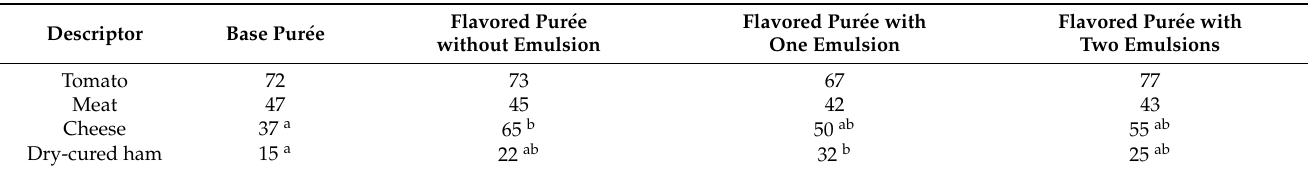
Table 2. Percentage of consumers that identified each one of the relevant flavors (tomato, cheese, dry-cured ham, and meat) in the different pasta pur é es in the free elicitation